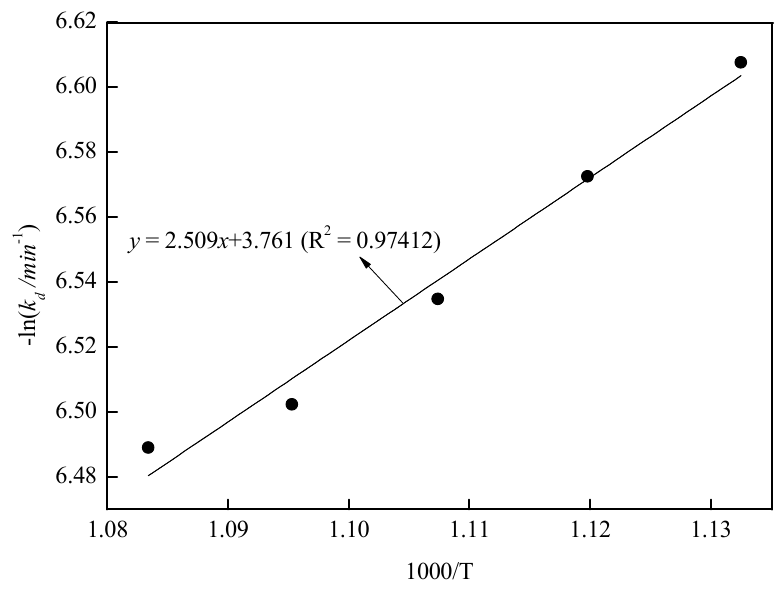
◦ C) and − ln k ) and − ln k d . d . Figure 14. The relationship between 1000/(T/°C